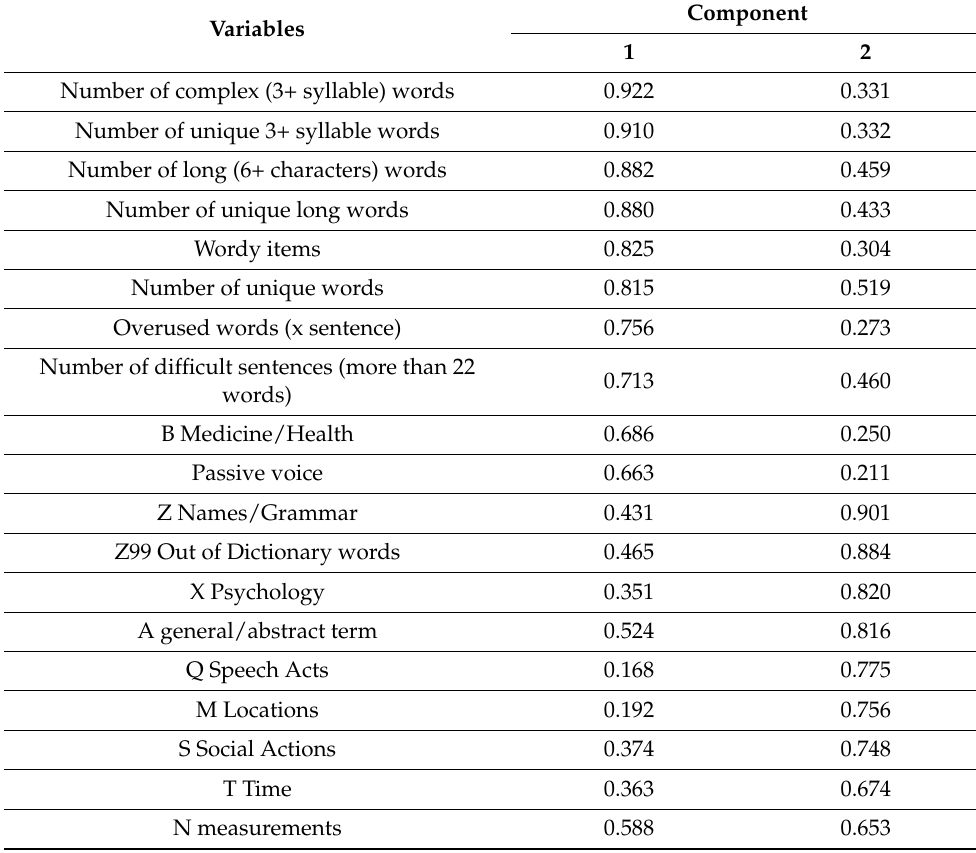
Table 4. Factor Analysis—Rotated component loadings of